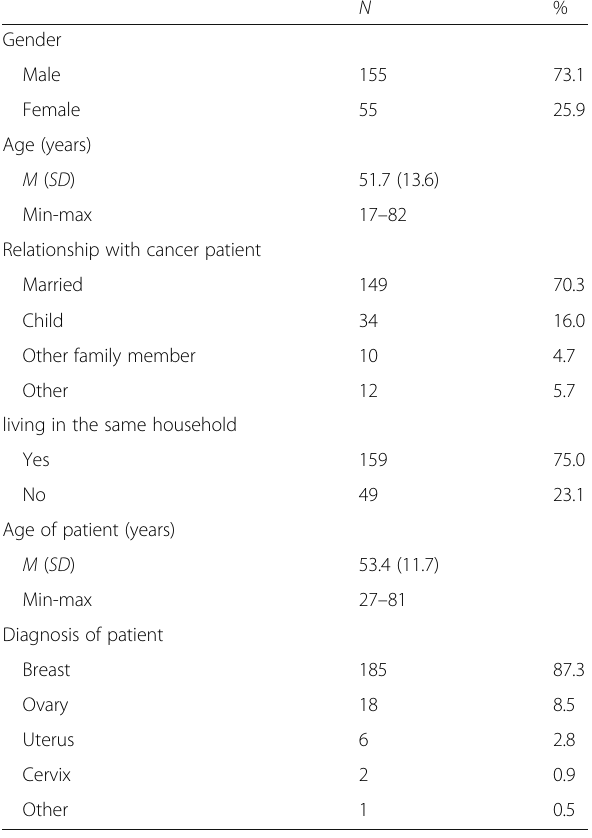
Table 1 Sociodemographic and medical characteristics (CONGO study